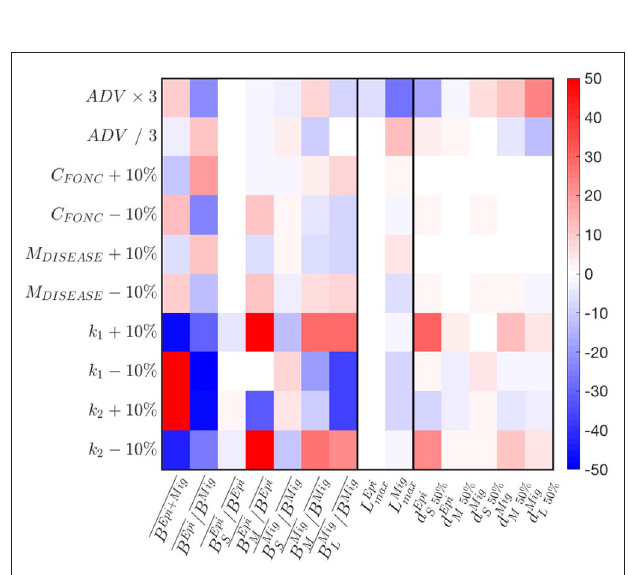
FIGURE 6 | Sensitivity of APECOSM-CC to food-web parameters. We test variations around ± 10 % for the food-web parameters, × / 3 for the parameters controlling movement. The sensitivity is expressed as % variation compared to the reference simulation with the best parameter